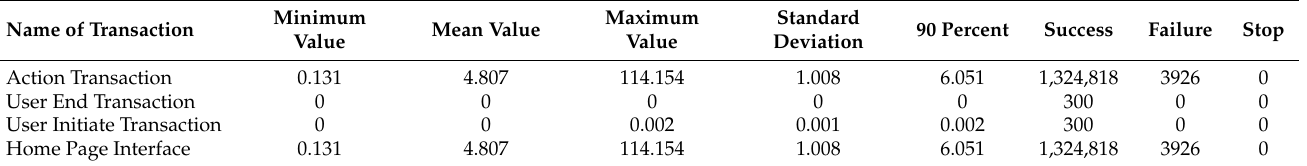
Table 5. Transaction summary diagram.